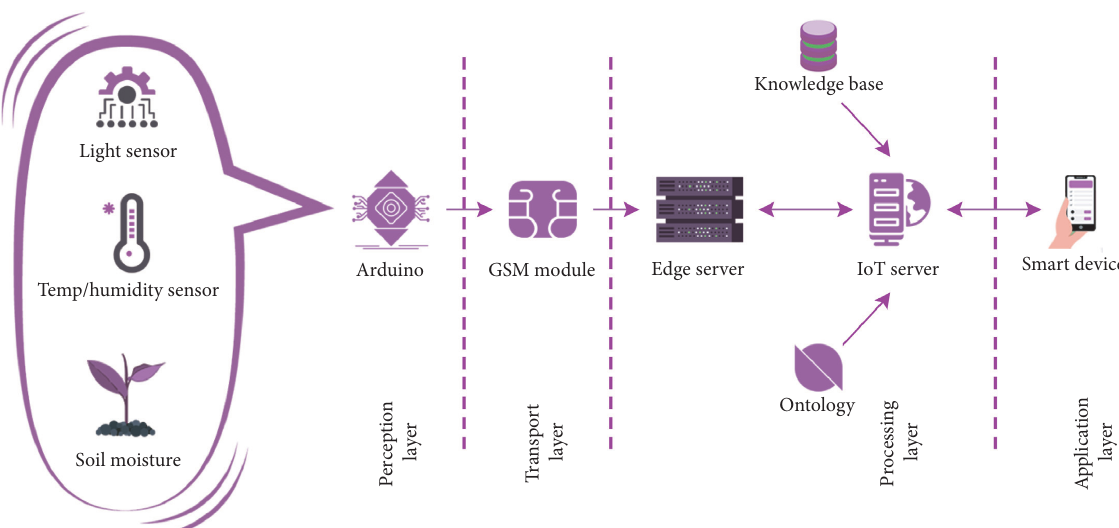
Figure 2: Hardware design for the integrated system.